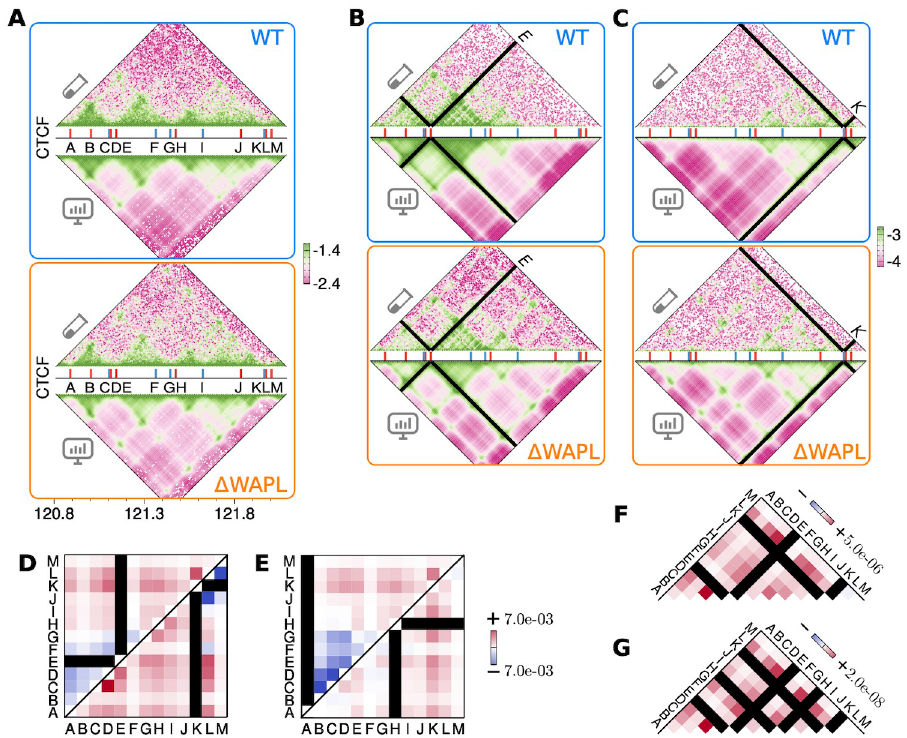
Fig 4. Comparing many-body contact predictions with MC-4C. (A) Comparing log 10 ( p ij ) from Hi-C and HLM at 10-kb resolution of a 1.28 Mb region on chr8, where there are thirteen CTCF-binding sites labeled from A to M. The genomic position of forward- and backward-oriented CTCF sites are marked with red and blue sticks, respectively. (B, C) Comparing log 10 ( p ijk ) from MC-4C and HLM at a viewpoint of site E and K, respectively. From the viewpoint of E (K), the values of PC between the model and the MC-4C experiment are 0.83 (0.81) and 0.71 (0.73) for the WT and Δ WAPL cells, respectively. (D) Cell-line difference of the predicted three-body contacts, namely p D WAPL the CTCF-binding sites from the viewpoint of A, E and (E) H, K, respectively. (F, G) Cell-line difference of four- and five-body contacts from double- and triple-anchored viewpoints, whose positions are marked with the black strips. The numbers label the maximum amplitudes of